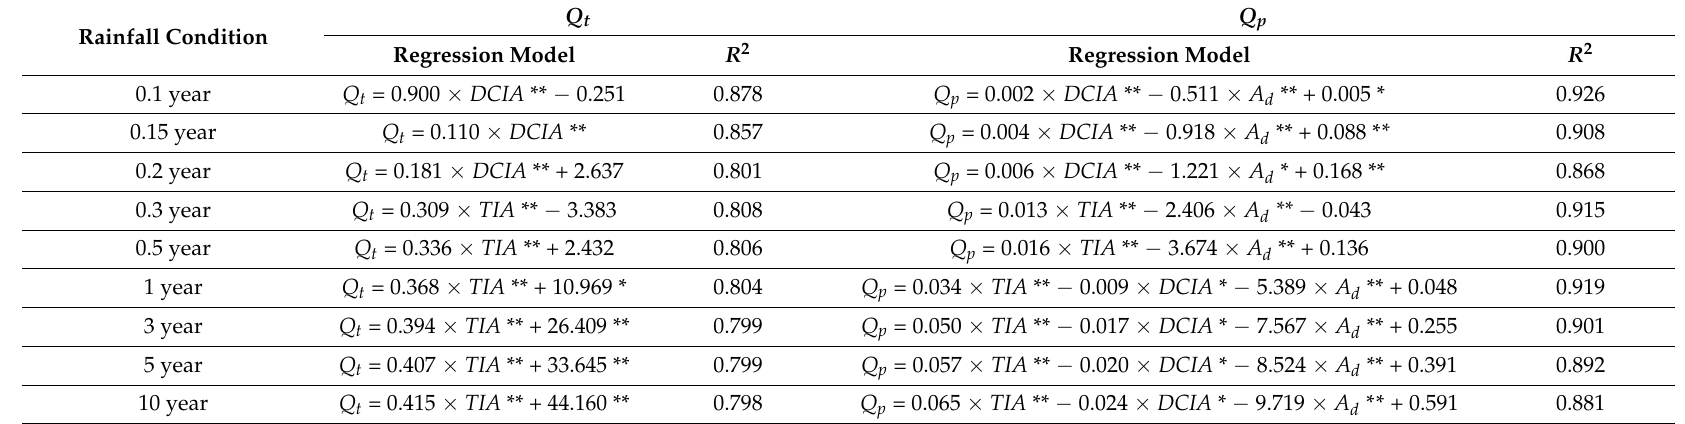
Table 4. Regression models for total runoff depth ( Q t , mm) and peak runoff depth ( Q p , mm/min) with spatial pattern